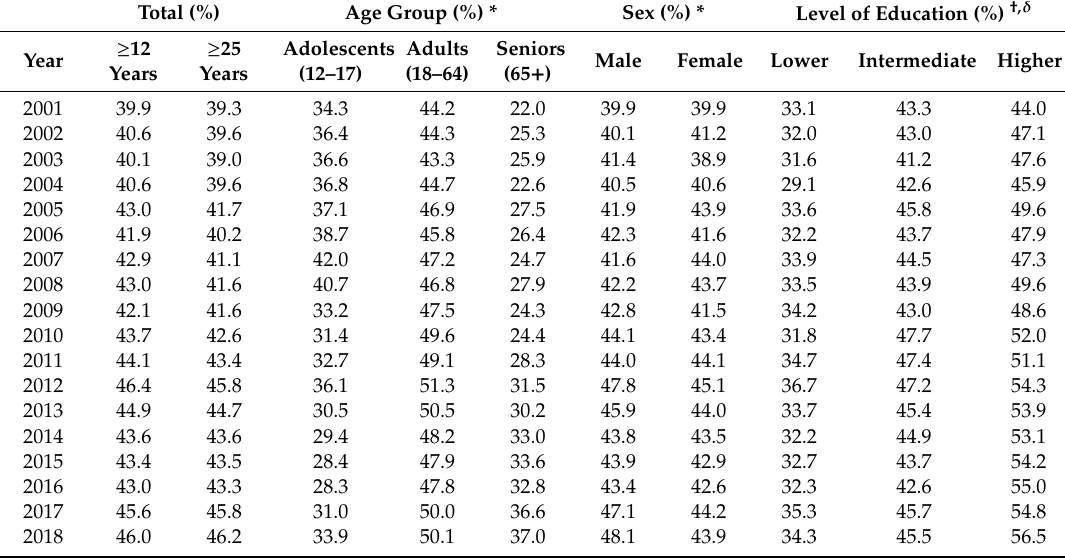
Table A2. Adherence levels to the Dutch physical activity guidelines in percentages, stratified by age groups, sex, and level of education.